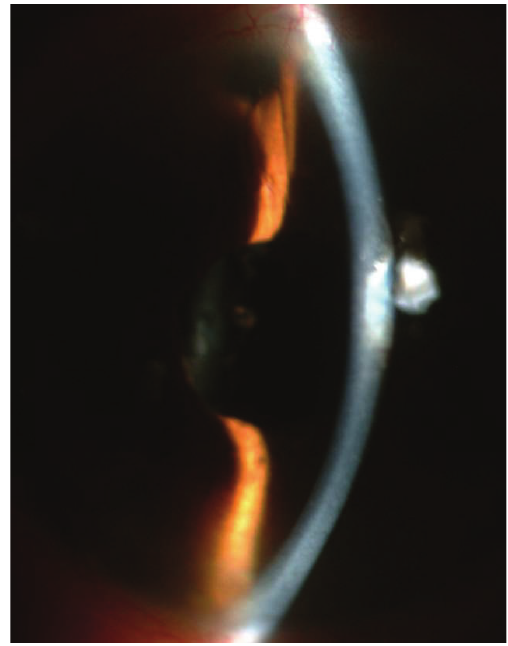
Figure 5: Postoperative slit-lamp photograph of the right eye in case 1. Anterior chamber was deep in the presence of a patent iridectomy,